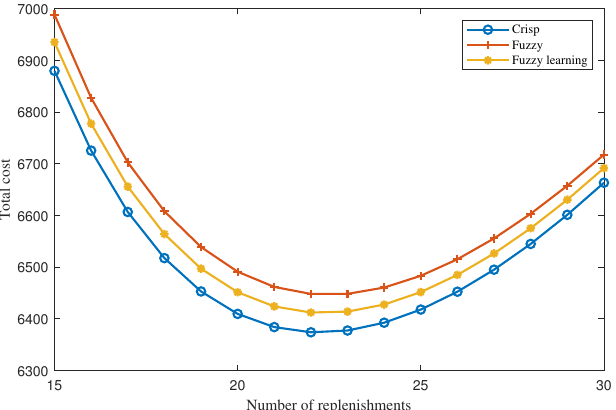
Figure 2. Total cost versus the number of replenishments for the three